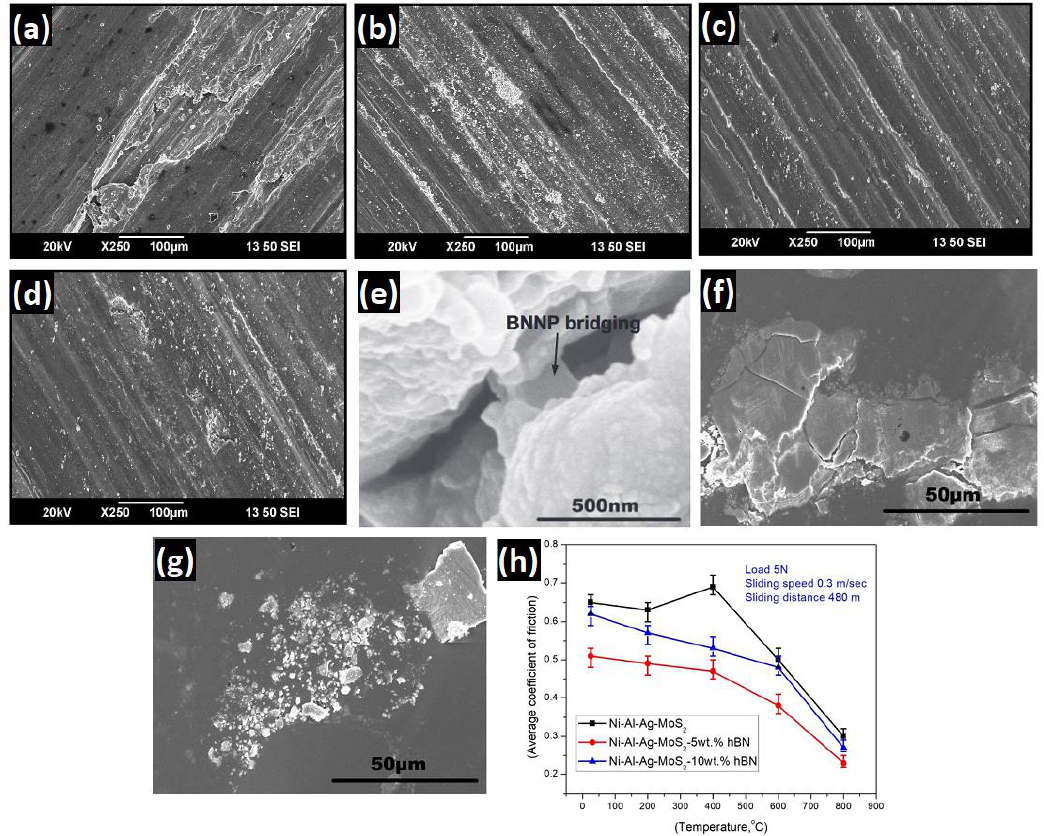
Figure 19. SEM micrograph of worn surface of; pure AA6082 ( a ) and AA6082 composite containing; TiB 2 ( b ), TiB 2 + h-BN ( c ), h-BN particles ( d ) (Reprinted with permission from Elsevier, Copyrights 2016) [153]. SEM images of BNNP bridging on the worn surface ( e ), wear debris of the Ni 3 Al sample ( f ) and the BNNP/Ni 3 Al composite at 9 N ( g ) (Reprinted with permission from Elsevier, Copyrights 2019) [156]. ( h ) Variation of average coefficient of friction with temperature for composite coatings (Reprinted with permission from Elsevier, Copyrights 2019) [158].